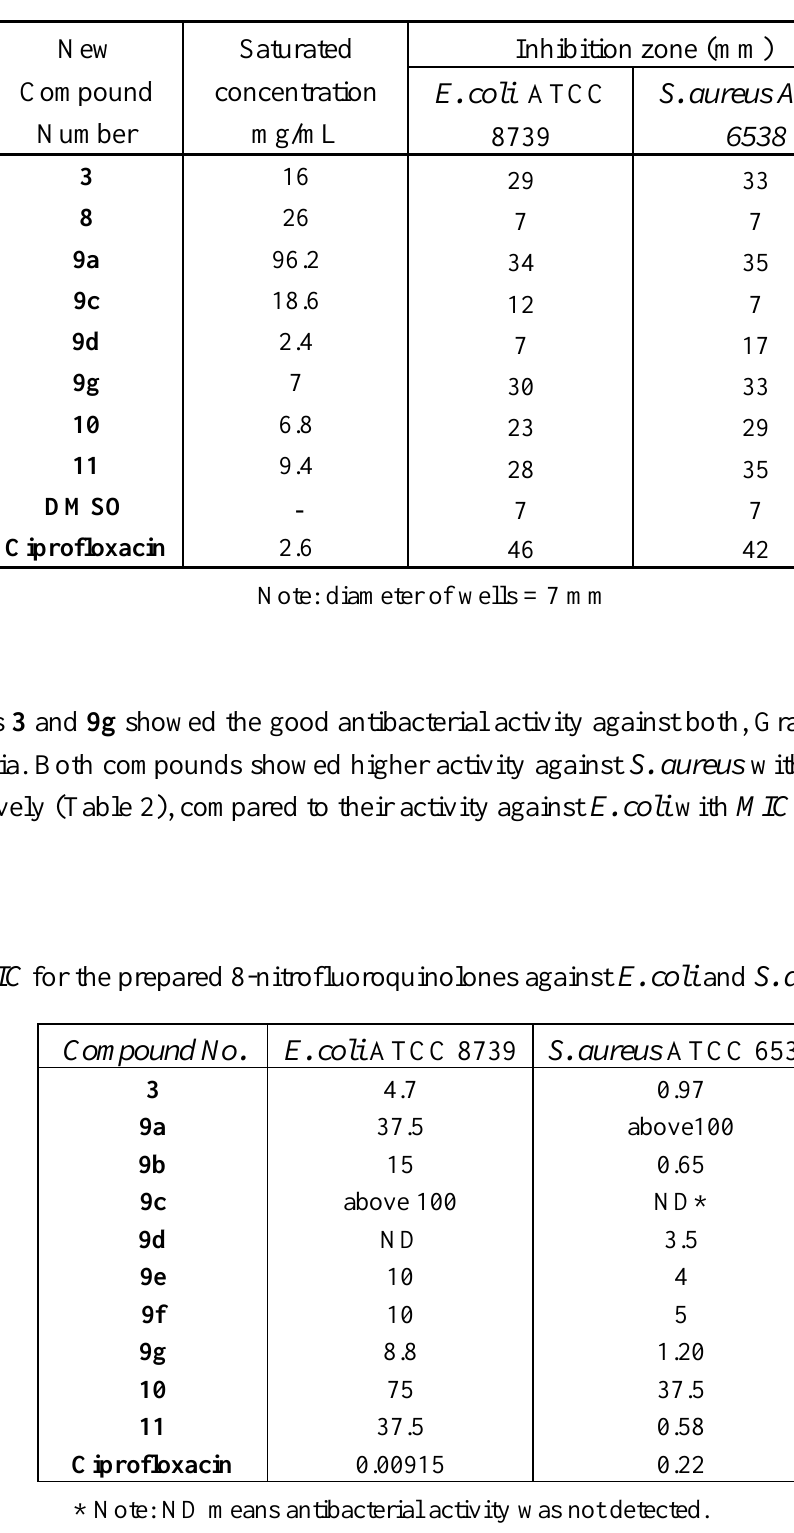
Table 1. Zones of inhibition of some synthesized compounds (at saturated concentration) against E. coli and S. aureus.